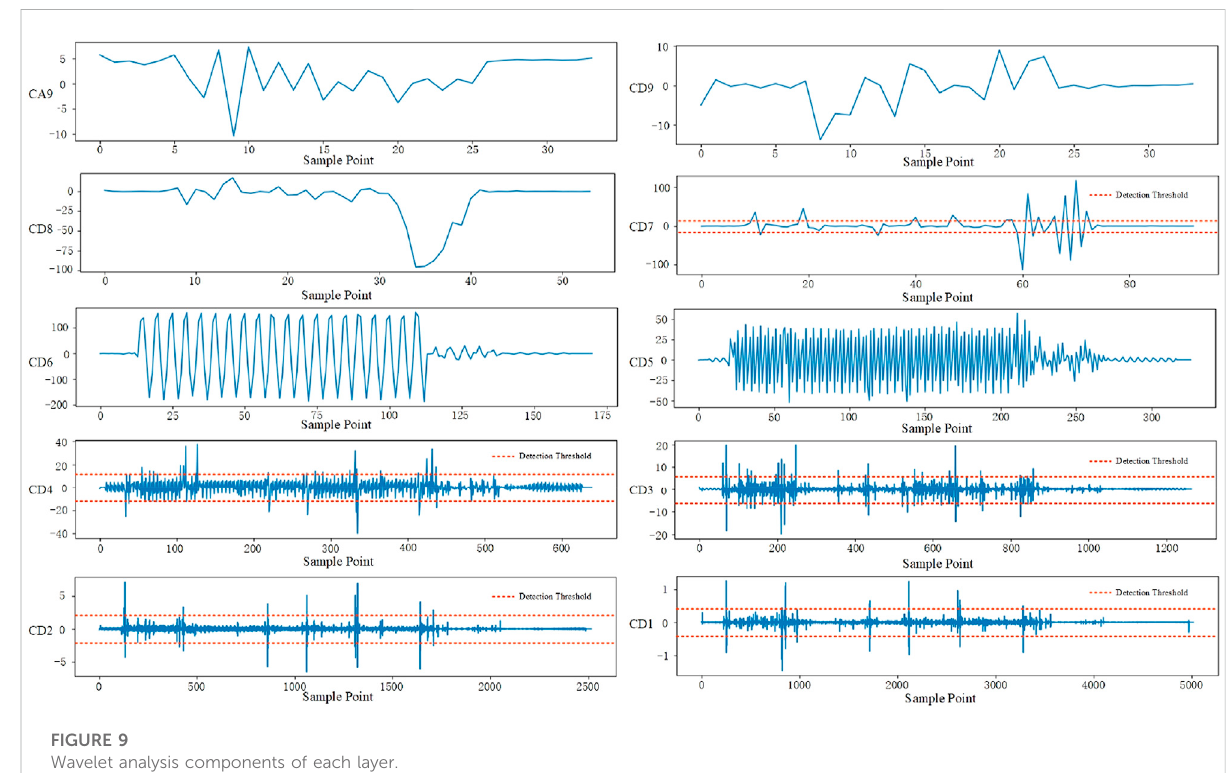
FIGURE 9 Wavelet analysis components of each layer.